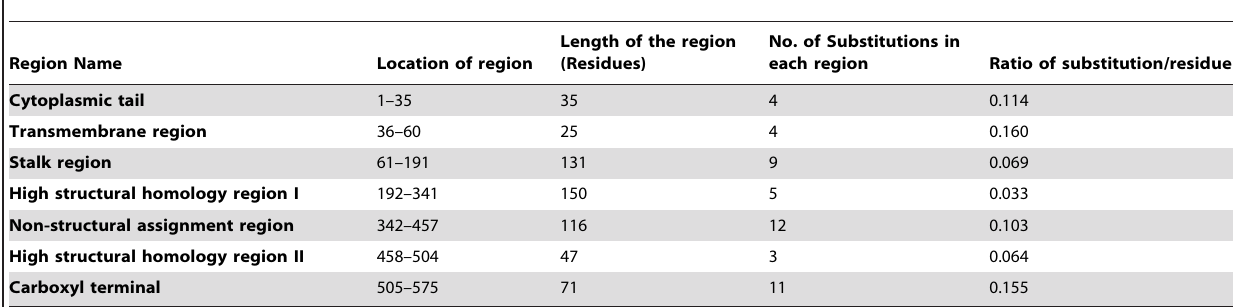
Table 4. Amino Acid substitutions of the Seven Regions of HN Gene (calculated using all available sequences from GenBank).